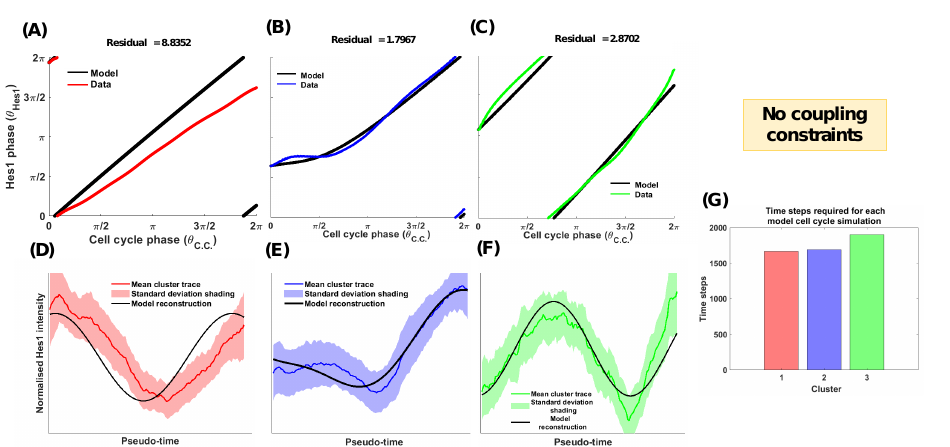
( i ) is op- Hes1 ( i ) , i = 1, 2, 3 superimposed Hes1